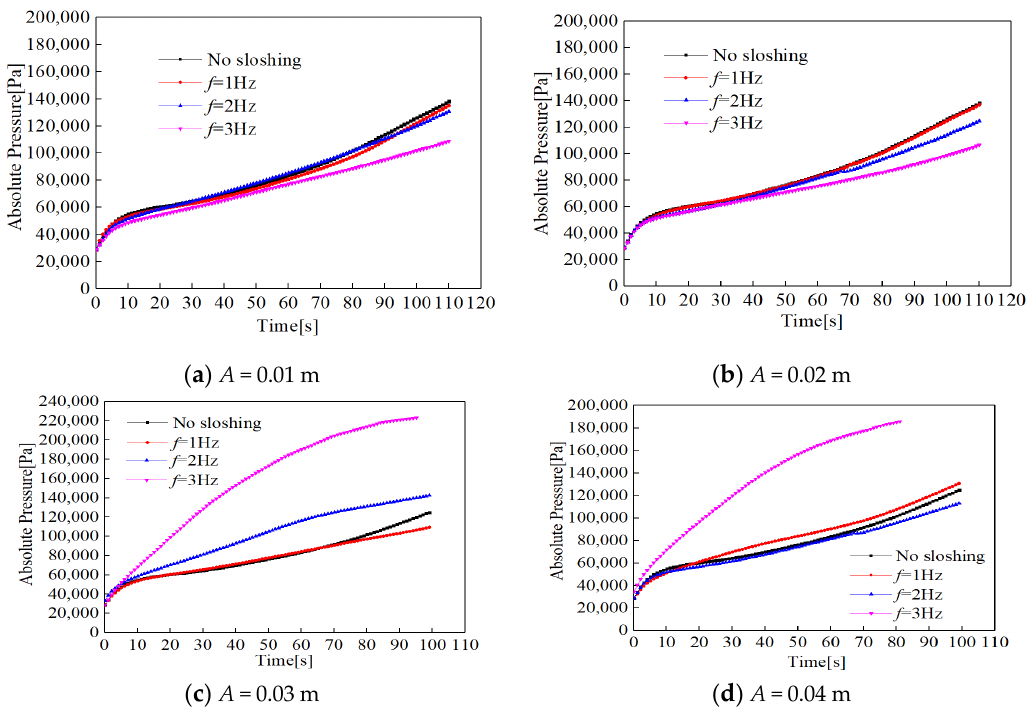
Figure 9. Pressure responses of the no-vent filling process under di ff erent sloshing frequencies with the condition of sloshing amplitude ( a ) A = 0.01 m, ( b ) A = 0.02 m, ( c ) A = 0.03 m, and ( d ) A = 0.04